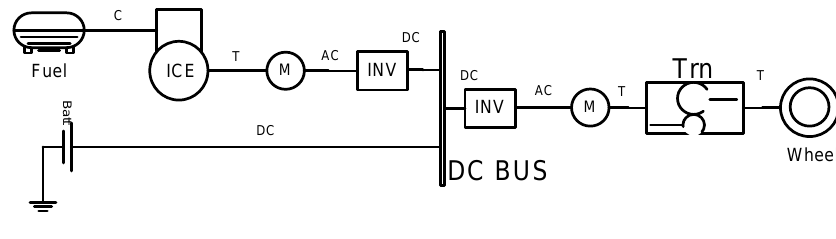
Figure 7. Schematic of series hybrid architecture with auxiliary power unit (APU) and